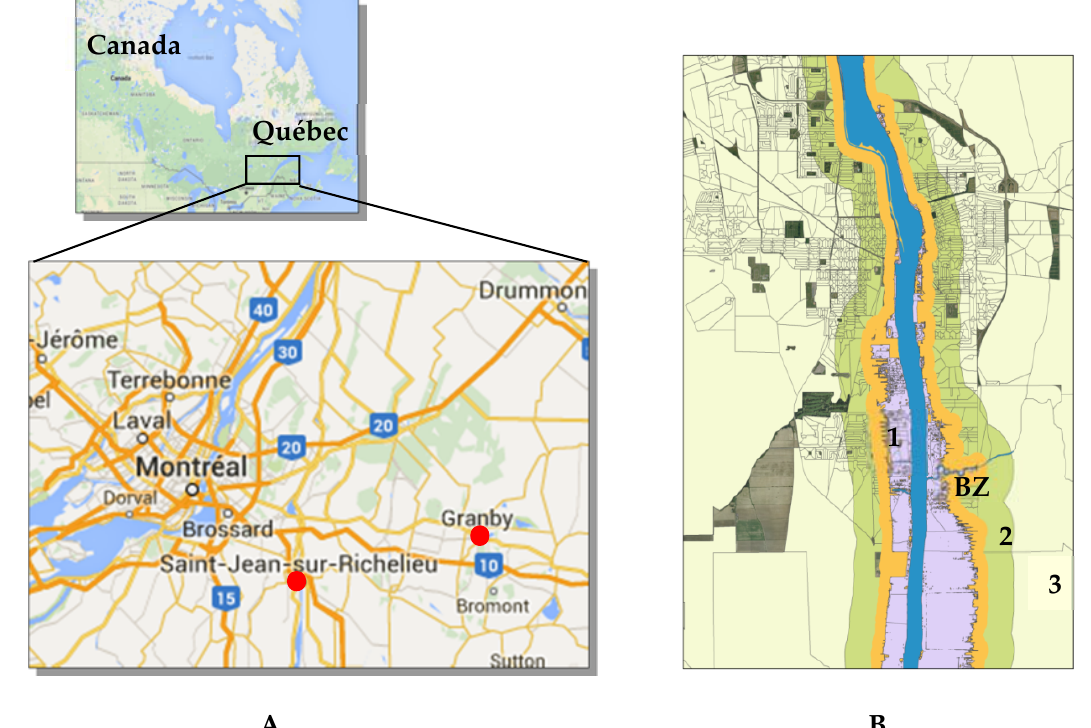
Figure 1. ( A ) Map of the province of Quebec in Canada, as well as the cities of Saint ‐ Jean ‐ sur ‐ Richelieu and Granby; ( B ) Map of the studied areas in Saint ‐ Jean ‐ sur ‐ Richelieu (1: Flooded area; 2 and 3: Control areas; BZ: Buffer zone (200 meters)).